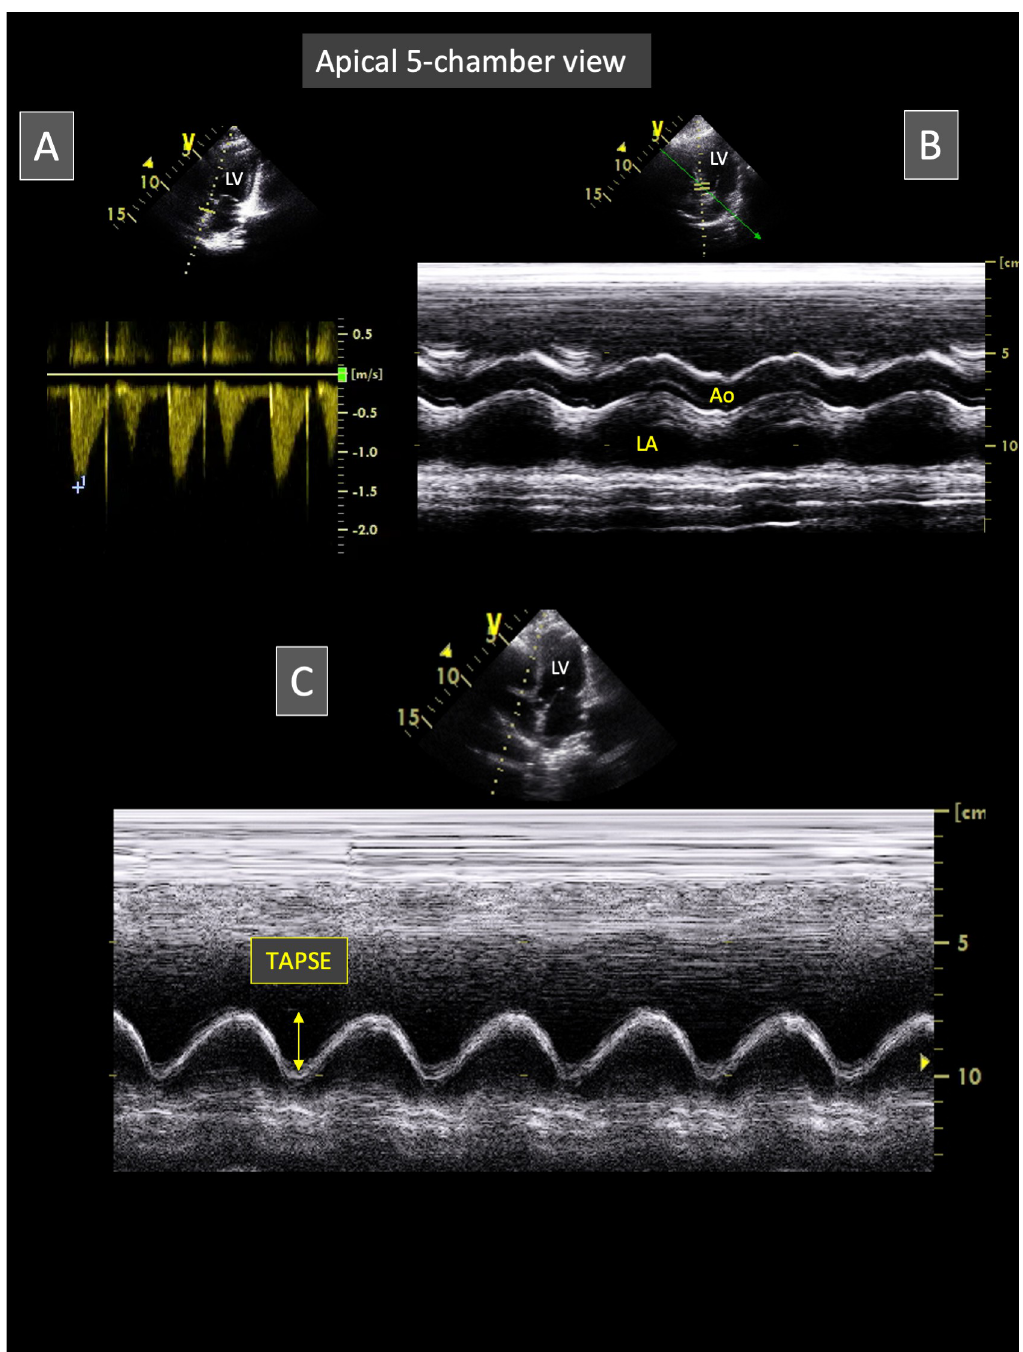
Fig 4. Representative apical 5-chamber view obtained from Borneo orangutans involved in the study. This view allows to obtain aortic flow recordings using continuous-wave Doppler mode (A). Video loops of this view can also be recorded for post- processing measurements of the left atrium and the aorta using the anatomic M-mode technique (B). For this purpose, the M- mode line is positioned perpendicular to left atrial and aortic walls (B). Lastly, by slightly tilting the probe from this position, the M-mode line can also be placed through the lateral segment of the tricuspid annulus for optimal measurement of the tricuspid annular plane systolic excursion (TAPSE; C). Ao : aorta; LA : left atrium; LV : left ventricle .